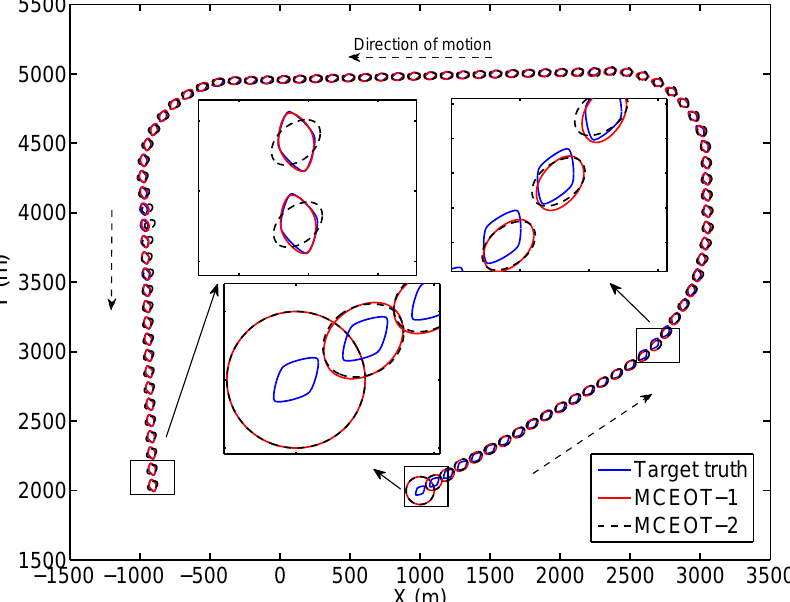
Figure 3. Trajectory of the complex extended object in scenario A (the blue solid line is for the true object, the red solid line and black dash line are for MCEOT-1 and MCEOT-2, respectively).